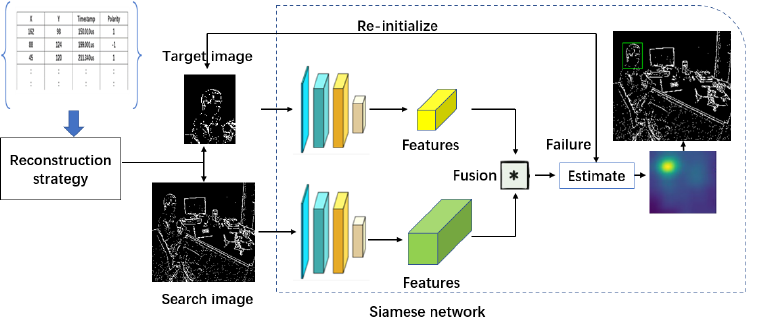
Figure 4. This picture shows an event camera-based tracker using the Siamese network, with feature extraction of the target image and search image using a shared weight